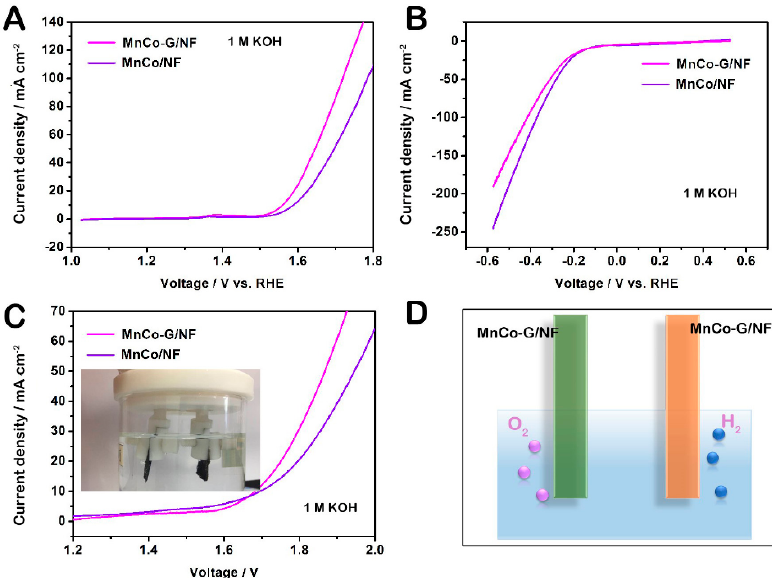
Figure 5. ( A ) OER and ( B ) HER polarization curves of MnCo-G and MnCo catalysts loaded onto nickel foam substrate; ( C ) full water splitting characteristics in a two-electrode configuration for the two samples; ( D ) schematic image for the full water splitting process.